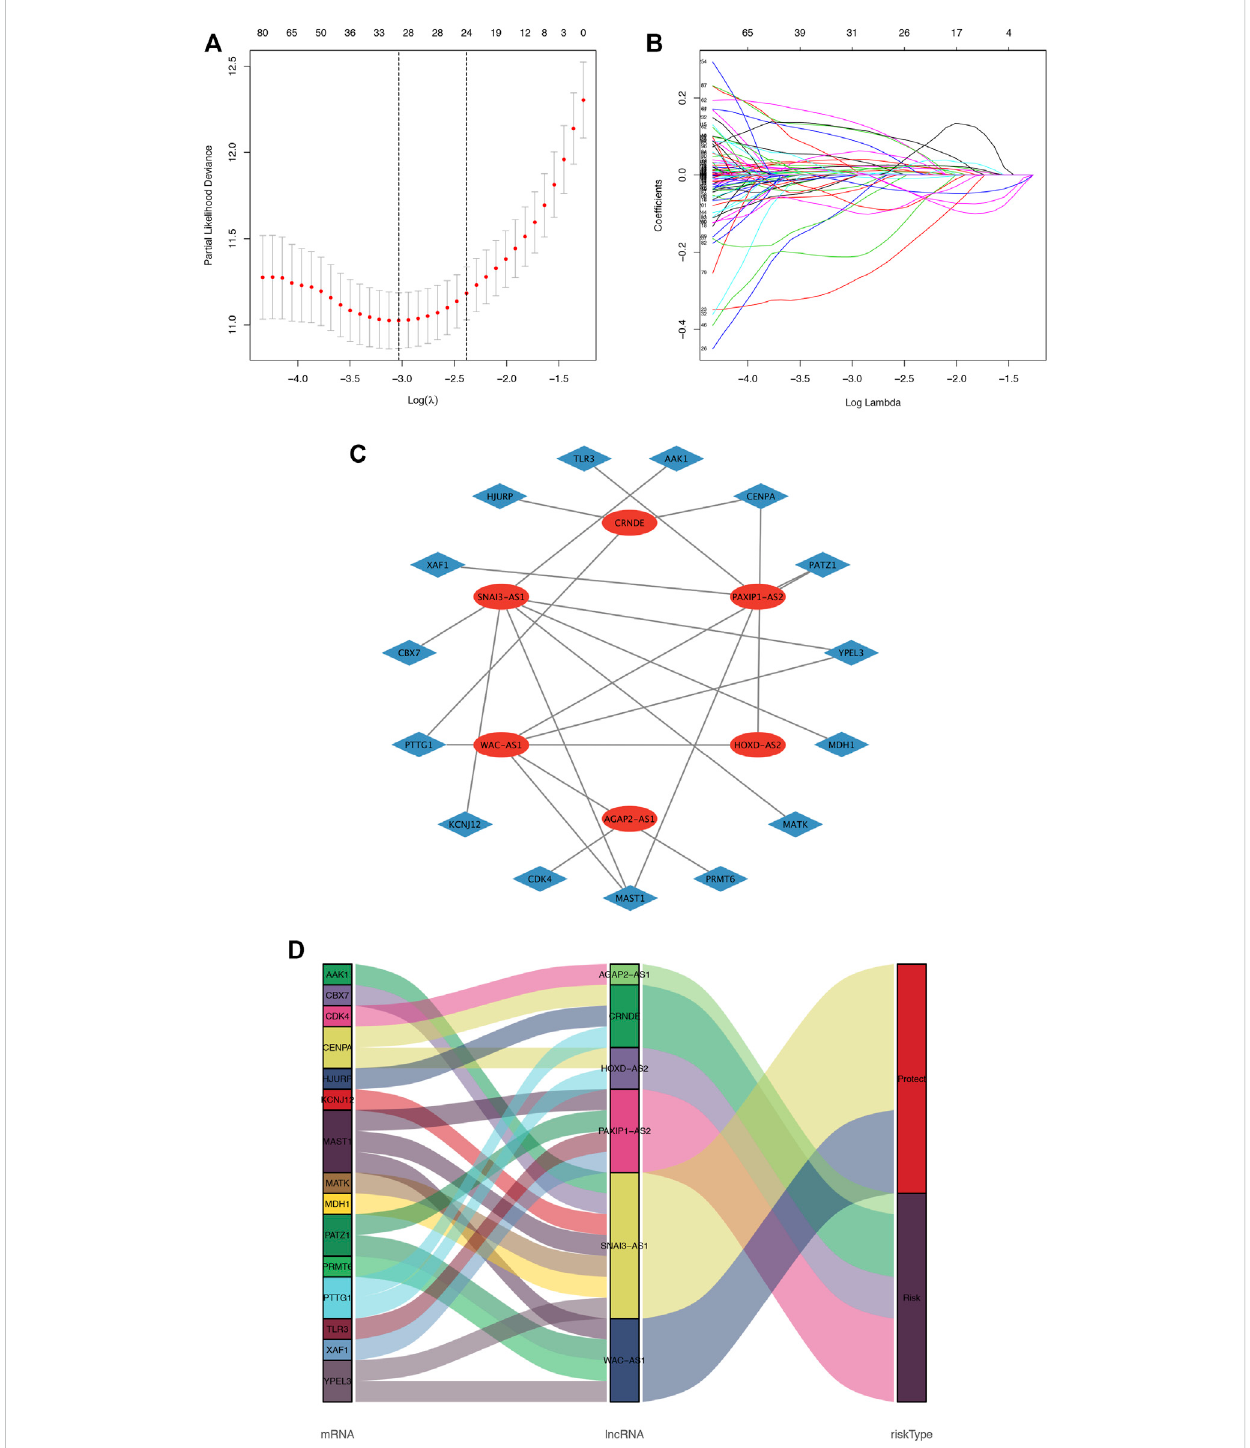
FIGURE 1 Cellular senescence-related lncRNA selection utilizing the LASSO model and the coexpression network and Sankey diagram. (A) . LASSO coef fi cient values and vertical dashed lines generated at the best log (lambda) values, (B) . LASSO coef fi cient curves for SRlncRNAs. (C) . The coexpression network between SRlncRNAs and mRNAs in glioma. The red nodes represent prognostic lncRNAs, and the sky-blue nodes represent mRNAs. (D) Sankey diagram showing the association between prognostic cell senescence-related lncRNAs, mRNAs, and risk